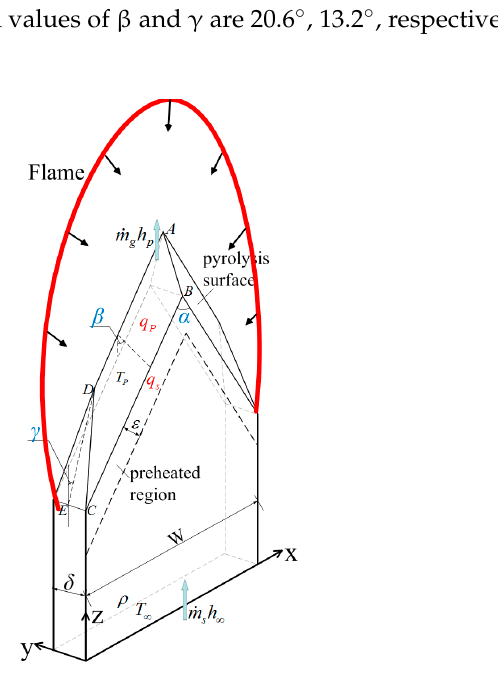
m h m h and s g p m g h p and m s h ∞ refer to the variation of enthalpy of gas s g p and are pyrolysis temperature, ambient